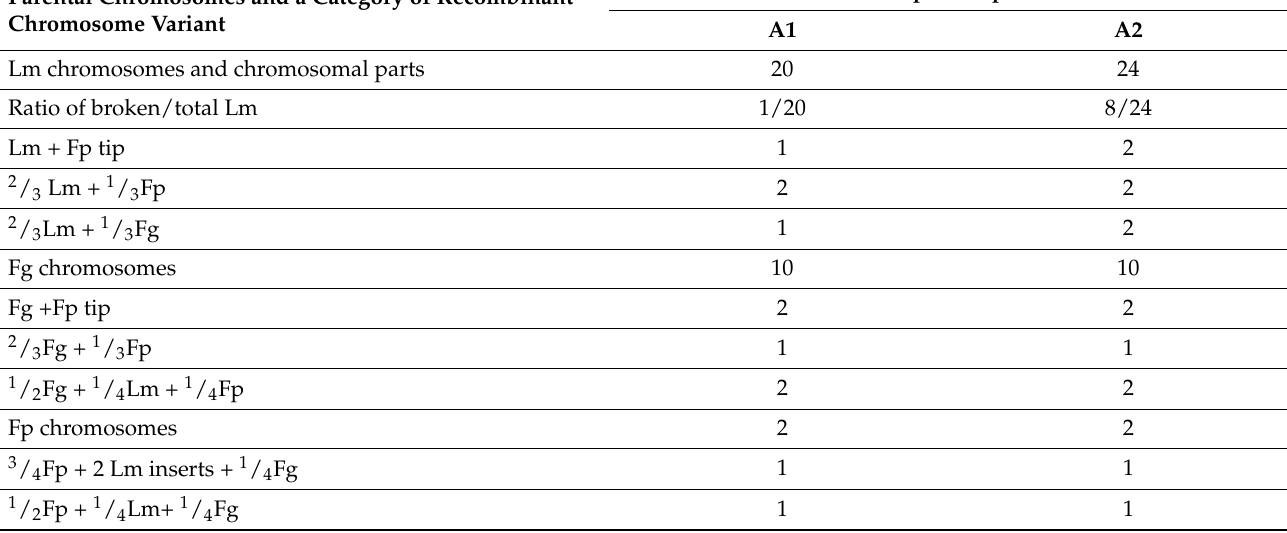
Table 2. Genomic complexity of super-recombinant F2 3-18 L. multiflorum × F. arundinacea revealed by GISH for its true parental and recombinant chromosomal components (structural analysis from Figure